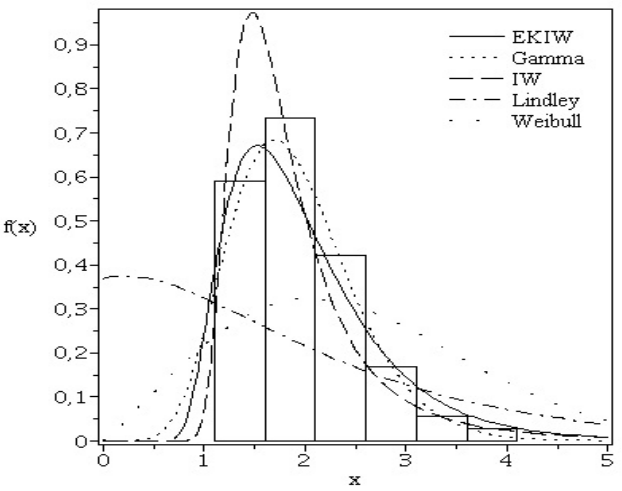
Fig. 3. Histogram and estimated